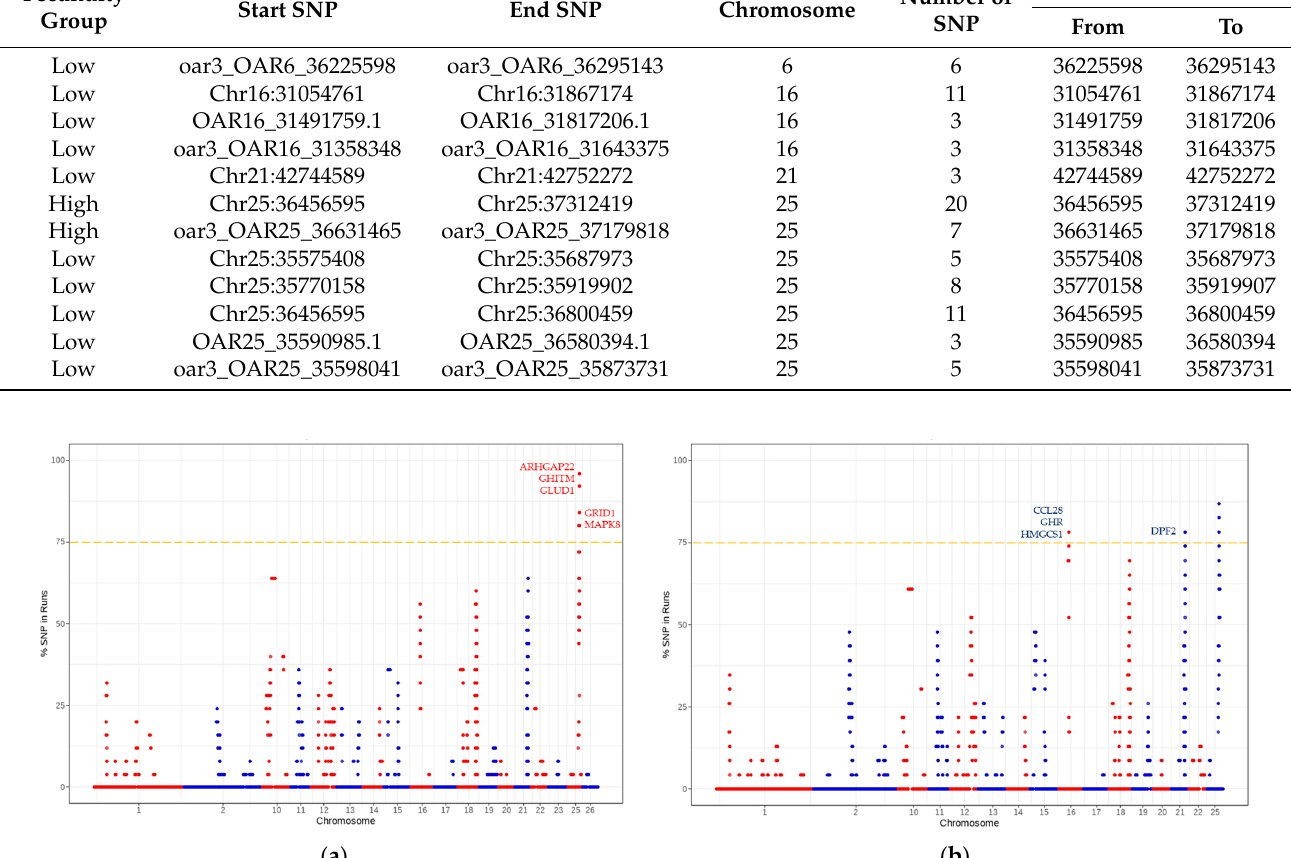
Table 1. Information of detected runs of homozygosity (ROH) in the genome of Katahdin sheep.